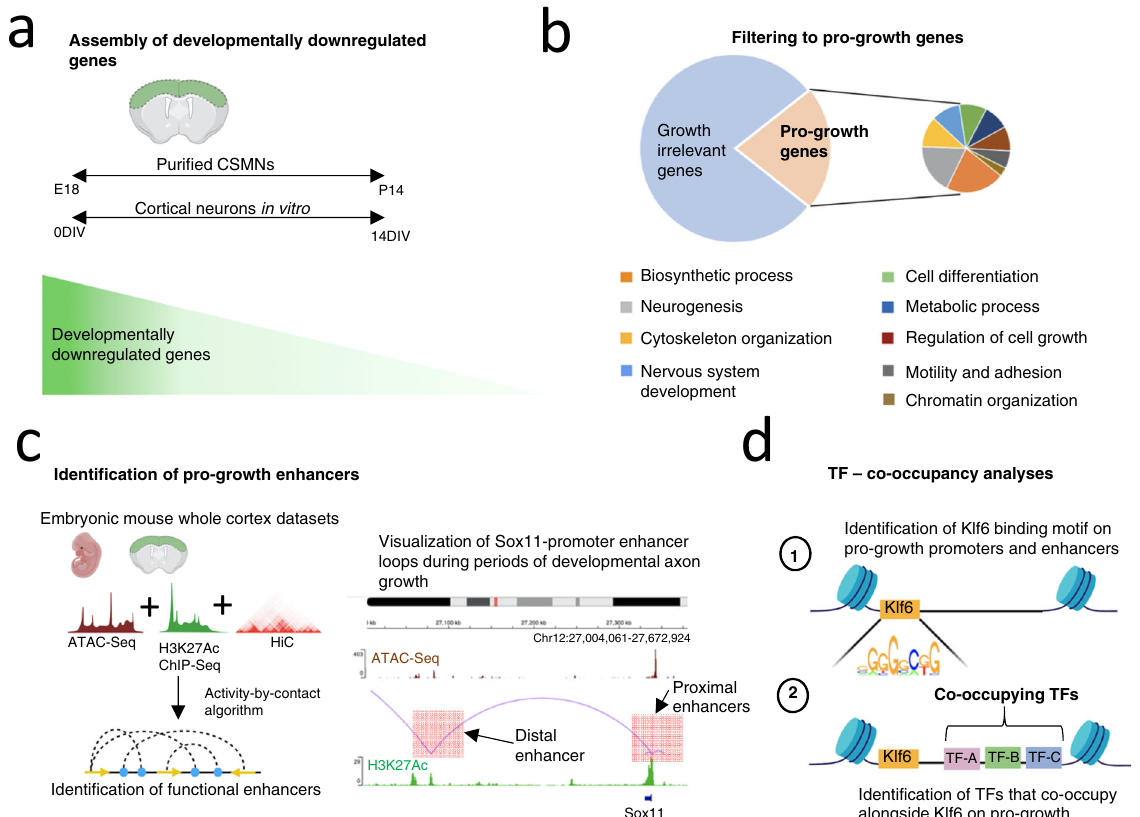
Fig. 1 Integrated bioinformatics pipeline identi fi es KLF6 partner TFs likely involved in the regulation of axon growth. a Time-course gene expression datasets from mouse cortical neurons were integrated to isolate genes that are downregulated across cortical maturation in vivo and in vitro (CSMNs, corticospinal motor neurons). b Gene Ontology analyses delineated developmentally downregulated genes that are likely growth relevant, based on functional enrichment in GO categories pertinent to axon growth. c Activity-by-contact (ABC), an enhancer – target gene pairing algorithm, de fi ned speci fi c enhancer regions genomewide, which modulate the expression of growth-relevant transcripts. Genome tracks are loaded to visualize the proximal and distal enhancer – promoter loops involved in the regulation of the pro-growth gene Sox11 during periods of developmental axon growth. ATAC-Seq pro fi les are shown in magenta and H3K27Ac pro fi les are shown in green. d TF co-occupancy analyses predicted TFs that co-occupy regulatory DNA alongside Klf6 to regulate the expression of growth-relevant